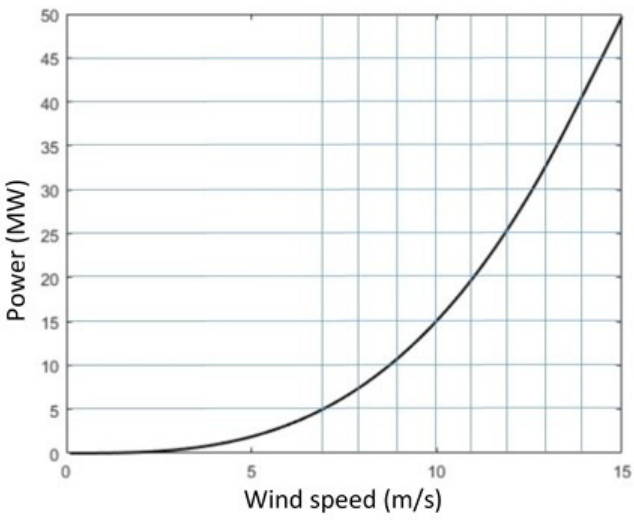
Figure 4. Available ship towing power (MW) versus wind velocity (m/s).